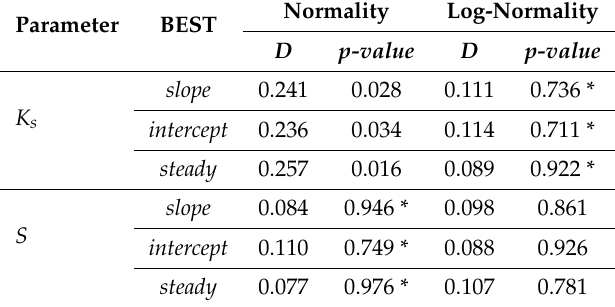
Table 5. Normality test Kolmogorov–Smirnov on the estimates of K s and S by the three BEST methods. Parameter